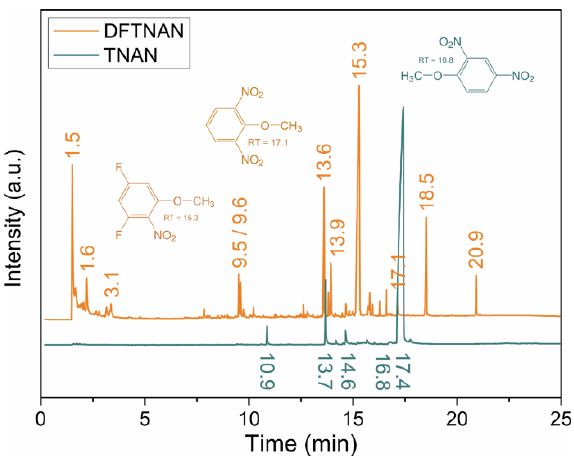
Figure 5. GC curves of the gaseous decomposition products of DFTNAN and TNAN after T-jump